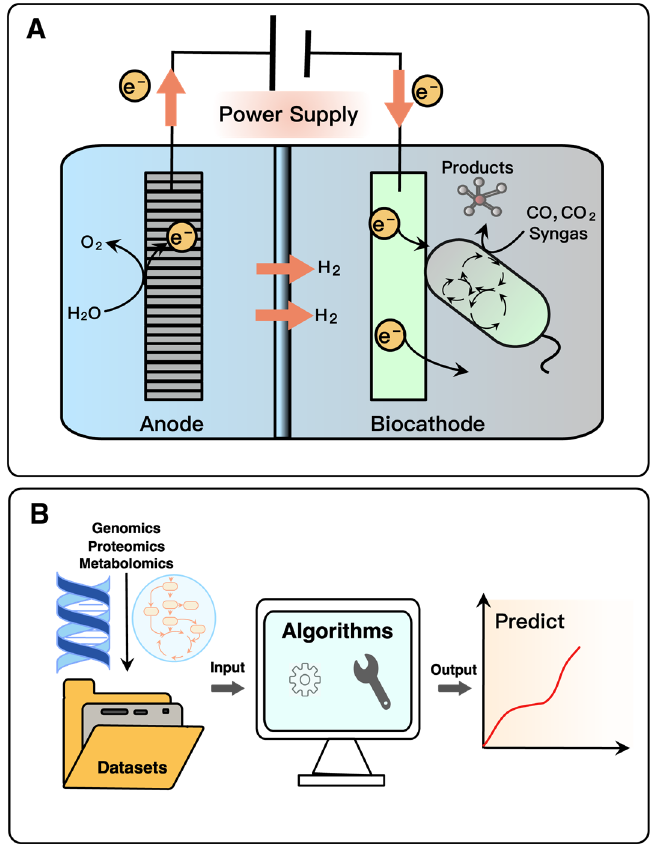
Figure 7. New tools in metabolic engineering: ( A ) microbial electrosynthesis (MES) and ( B ) machine learning (ML).